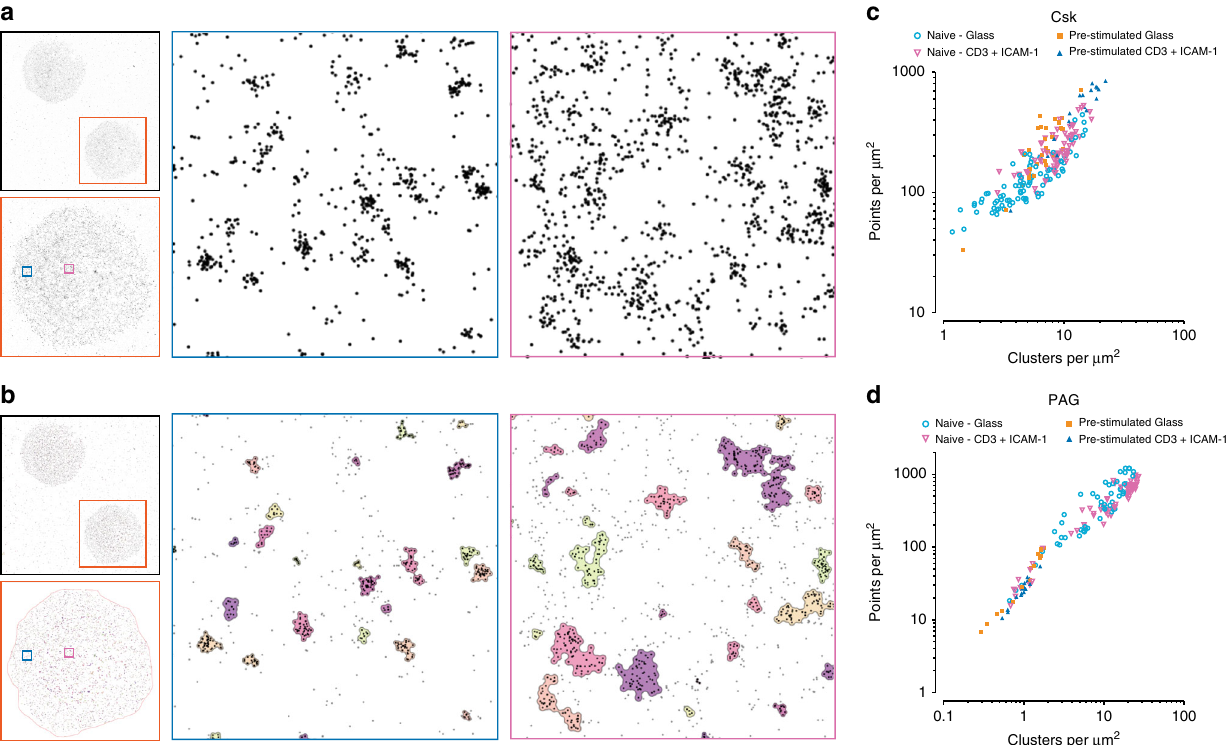
Fig. 4 Analysis of dSTORM data with Model 87B144. Activated primary human T cells stained for Csk showing either localized points ( a ), or resulting cluster outlines ( b ), of two regions (blue, peripheral, and magenta, central). Clustering data obtained from individual naive or pre-stimulated cells for Csk ( c ) or PAG ( d ) staining in either non-activating (supported on glass) or activating (anti-CD3 + ICAM-1) conditions. Data are from three independent experiments and are presented as median values from each cell; Csk, naive — glass: 85 cells, Csk, naive — CD3 + ICAM-1: 71 cells, Csk, Pre-stimulated